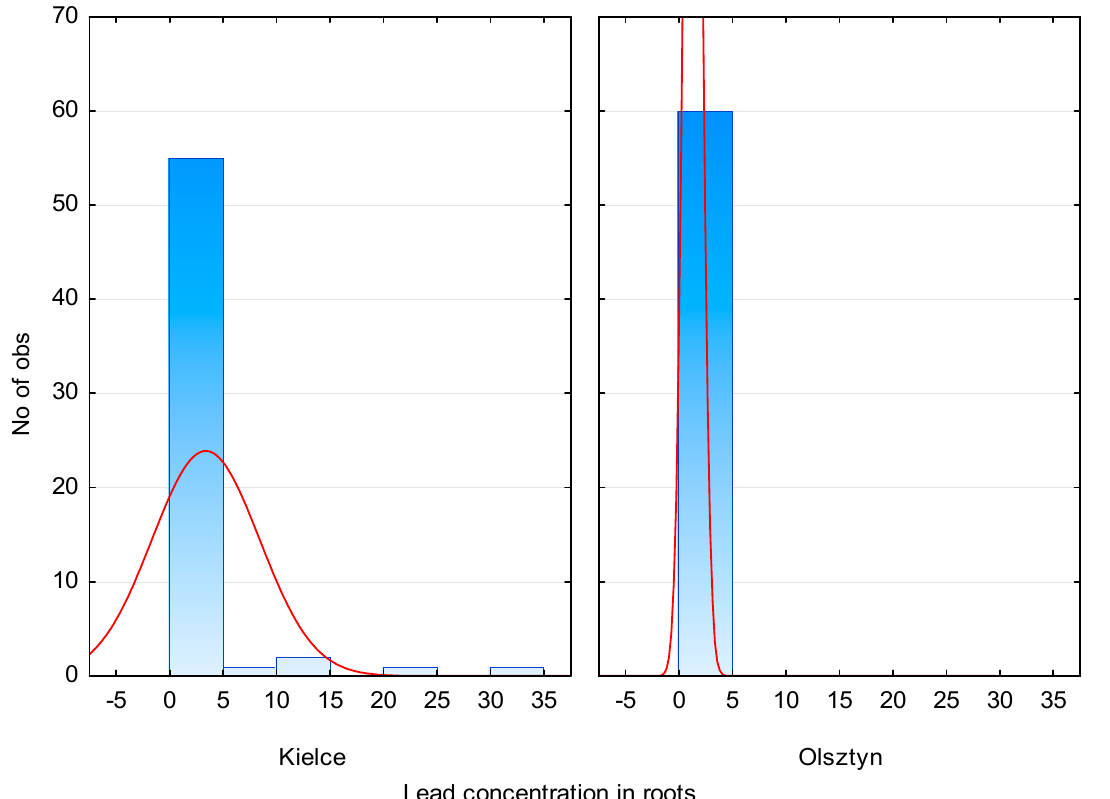
Figure 3. Diversification of lead content in the common dandelion’s roots from Kielce and Olsztyn.